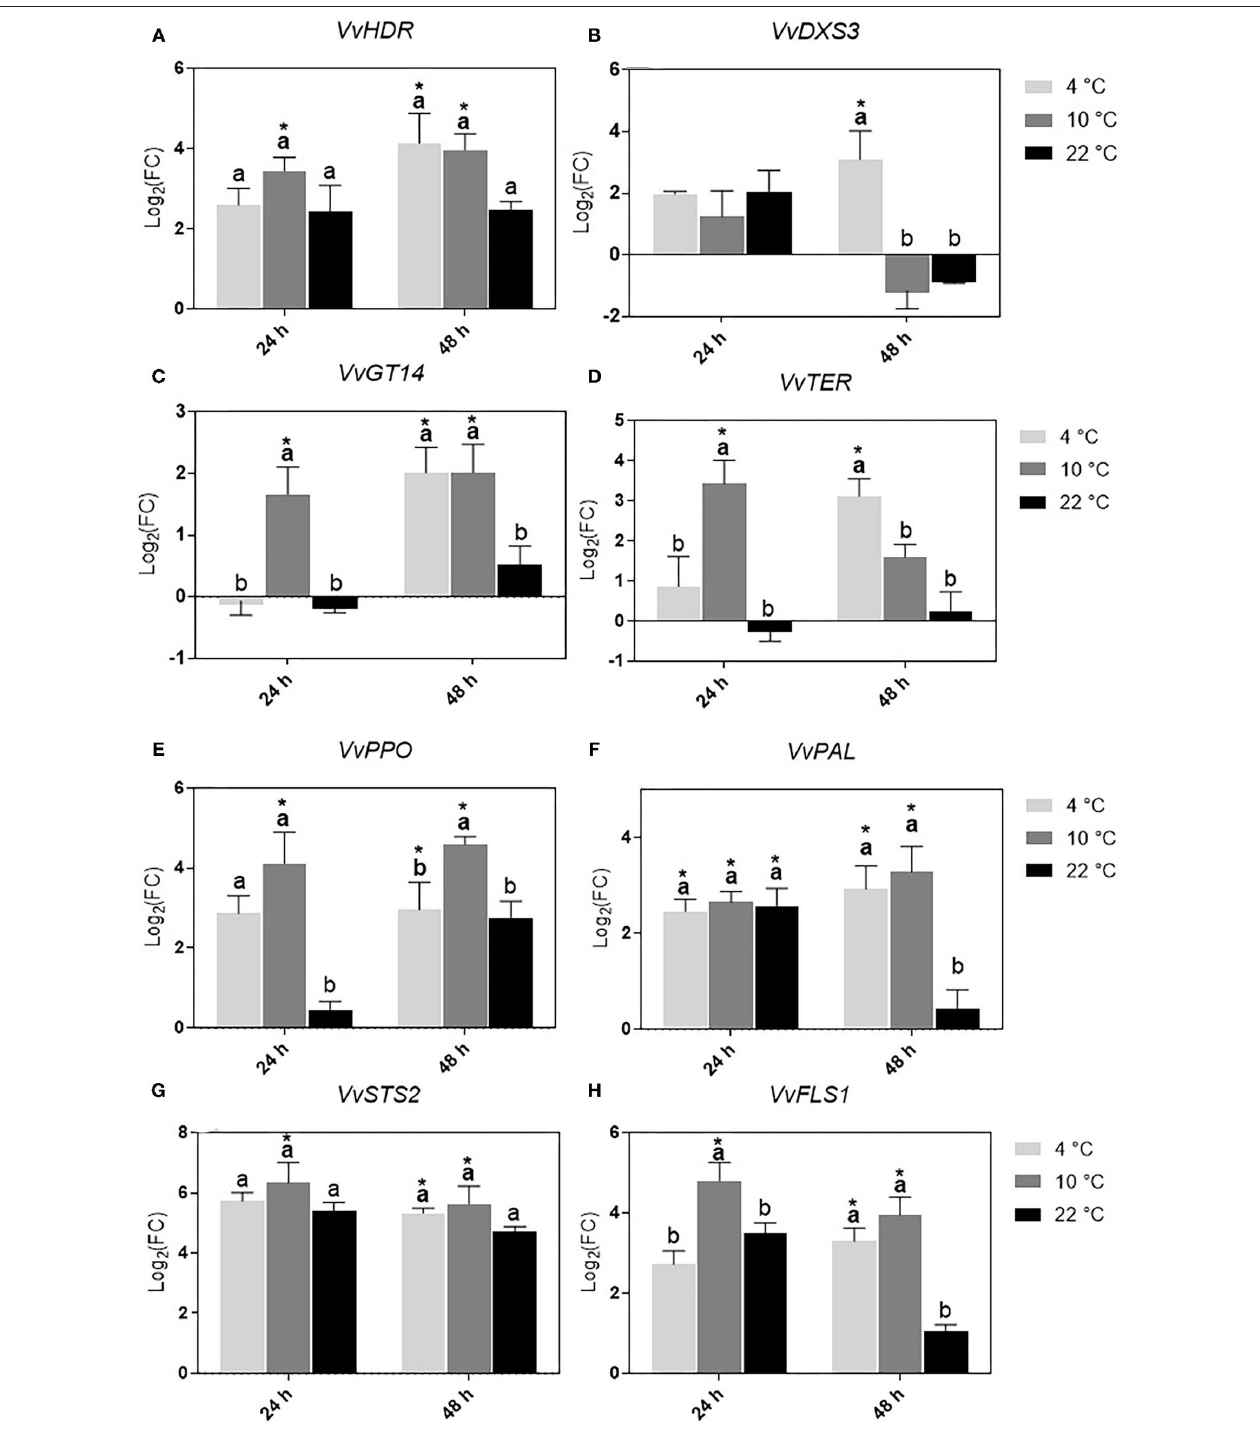
FIGURE 3 | Relative expression of VvHDR (A) , VvDXS3 (B) , VvGT14 (C) , and VvTER (D) , VvPPO (E) , VvPAL (F) , VvSTS2 (G) , and VvFLS1 (H) genes over sampling time in Vermentino berry skins following cooling treatment of grapes at 4 and 10 ◦ C for 24 and 48h and in control grapes at 22 ◦ C at the same time periods. The gray color scale represents different treatment temperatures (4, 10, and 22 ◦ C). Each bar represents the average of the expression level in the three analyzed biological and two technical replicates, normalized to the expression level at harvest (T0) and transformed in logarithmic scale as following: log 2 (FC) = log 2 [replicate /mean(T0)]. Different letters indicate statistically significant differences ( p ≤ 0.05) according to the results of the Tukey’s HSD test performed between treatments separately in each sampling time. Asterisks indicate statistically significant differences ( p ≤ 0.05) according to the results of the Tukey’s HSD test performed between treatments and T0